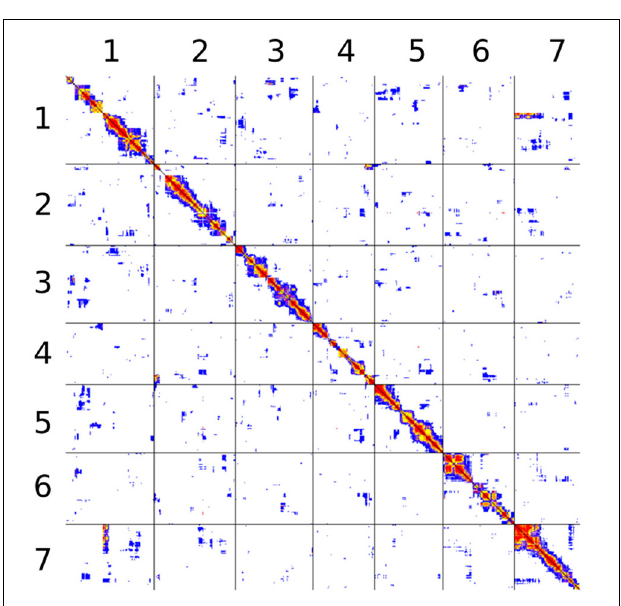
FIGURE 5 | Decay of linkage disequilibrium against physical distance. The value of Fisher’s exact test of association between 61,743 pairs of recombination blocks belonging to the same scaffold is represented as a function of the physical distance between block midpoints.